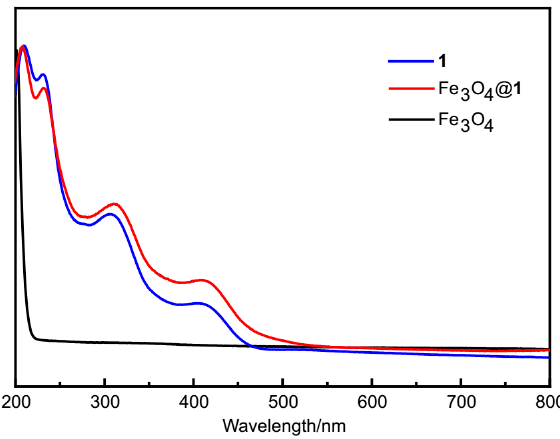
Figure 3. The UV-Vis spectra of 1 , Fe 3 O 4 @ 1 and Fe 3 O 4 .